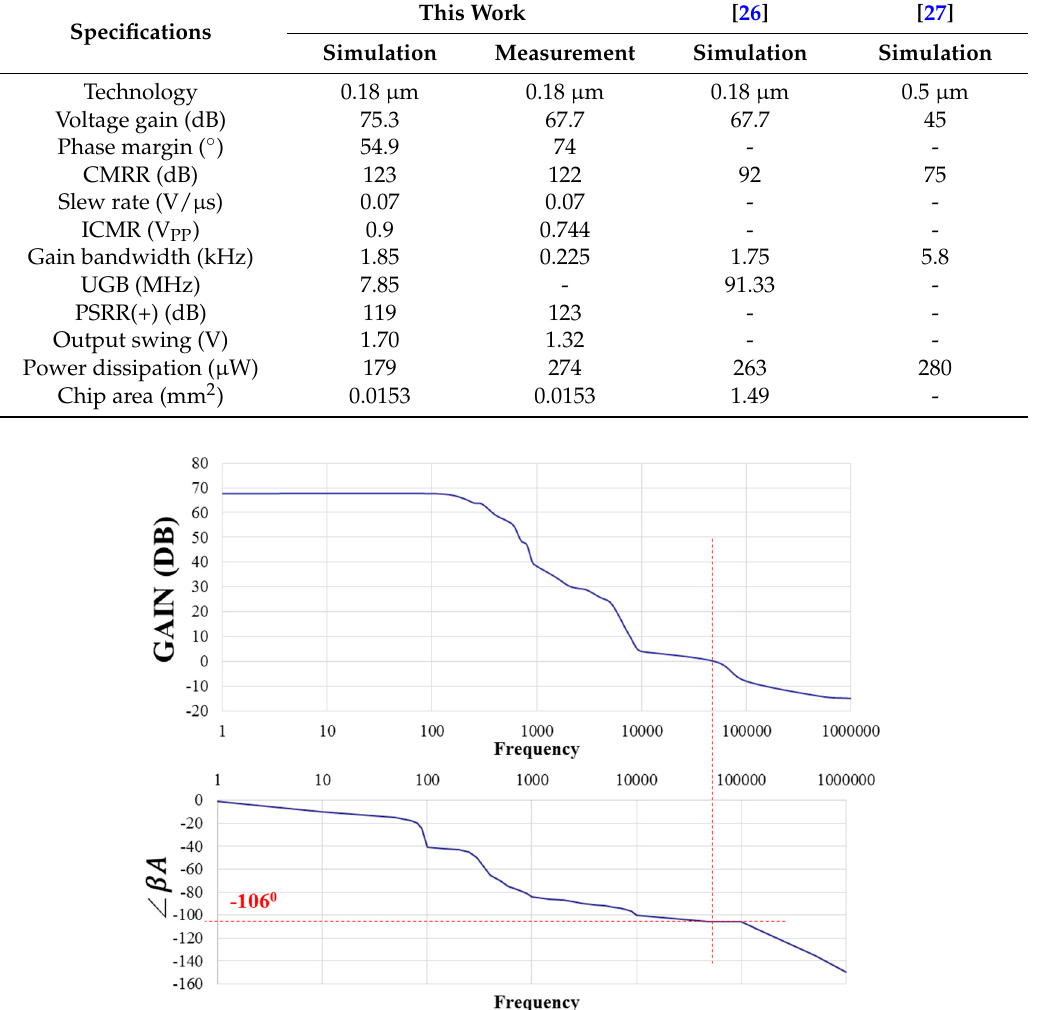
Figure 8. Measured open-loop gain of 67.7 dB and phase of 74° versus frequency (Hz).